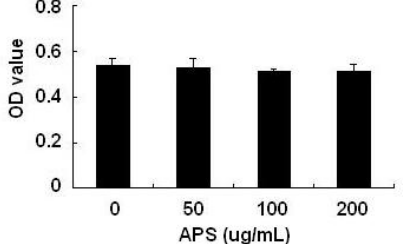
Figure 1. Effects of APS on THP-1 cell viability. A MTT assay was used to detect THP-1 cell viability after treatment with different concentration of APS (0, 50, 100 and 200 μ g/mL). All experiments were performed three times. Data are the means ± S.D. of three independent